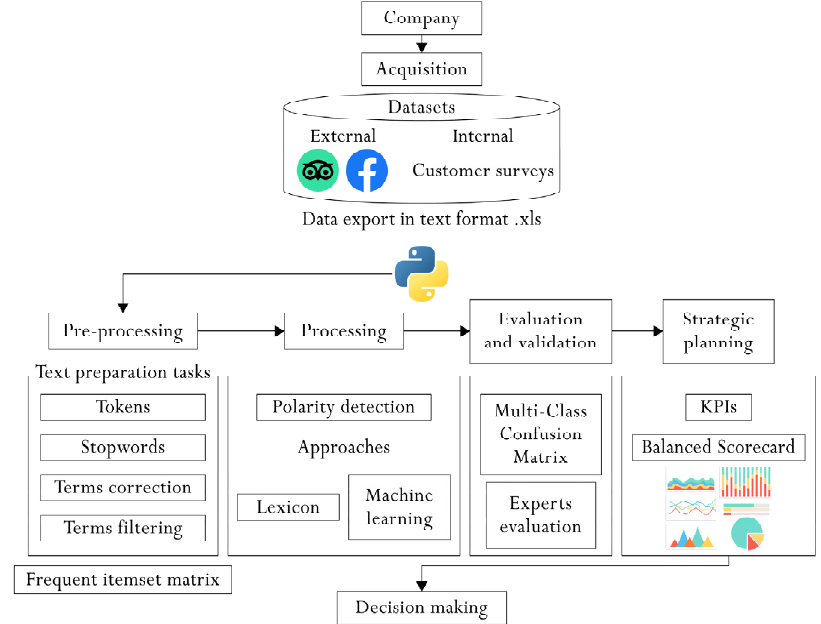
Figure 1. Research methodology.